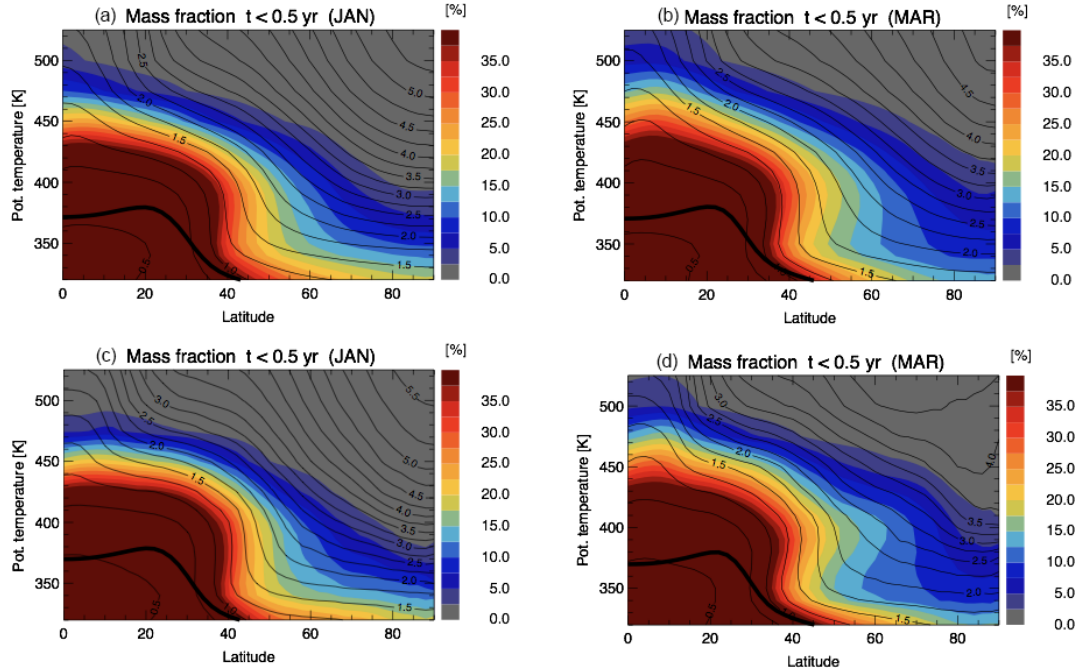
Figure 14. Zonal mean of air mass fractions (colour code) with transit times < 0.5 years for January (a, c) and March (b, d) from 2004 to 2016 climatology (a, b) and for 2016 only (c, d) against potential temperature. The contour lines show mean age in years and the thick black line shows the WMO